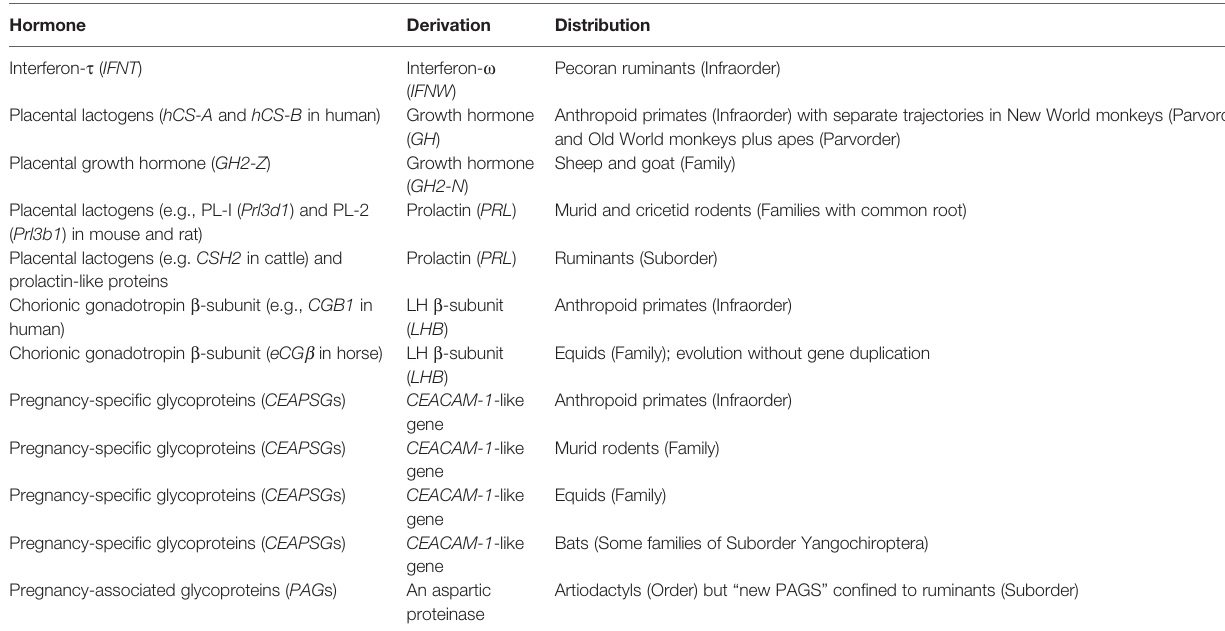
TABLE 2 | Protein hormones secreted by the placenta that evolved through gene duplication. Hormone